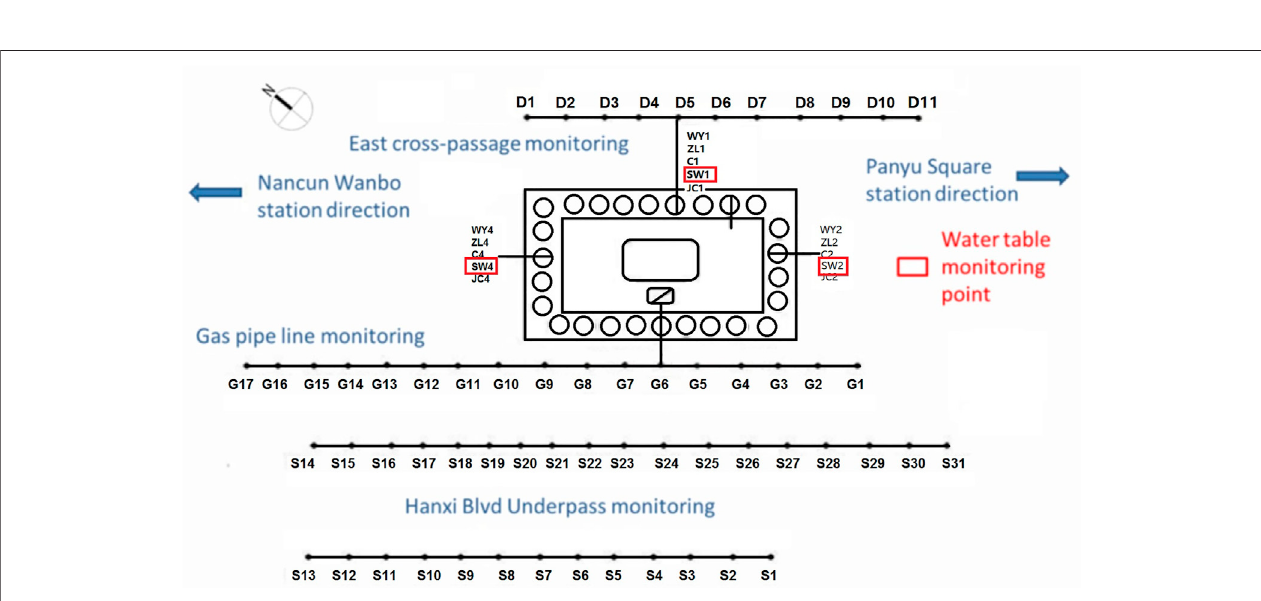
FIGURE 6 | Monitoring scheme (not to scale; WY, horizontal displacement; ZL, axial force in wallers; C, pile wall inclination; SW, water table; JC, settlement).